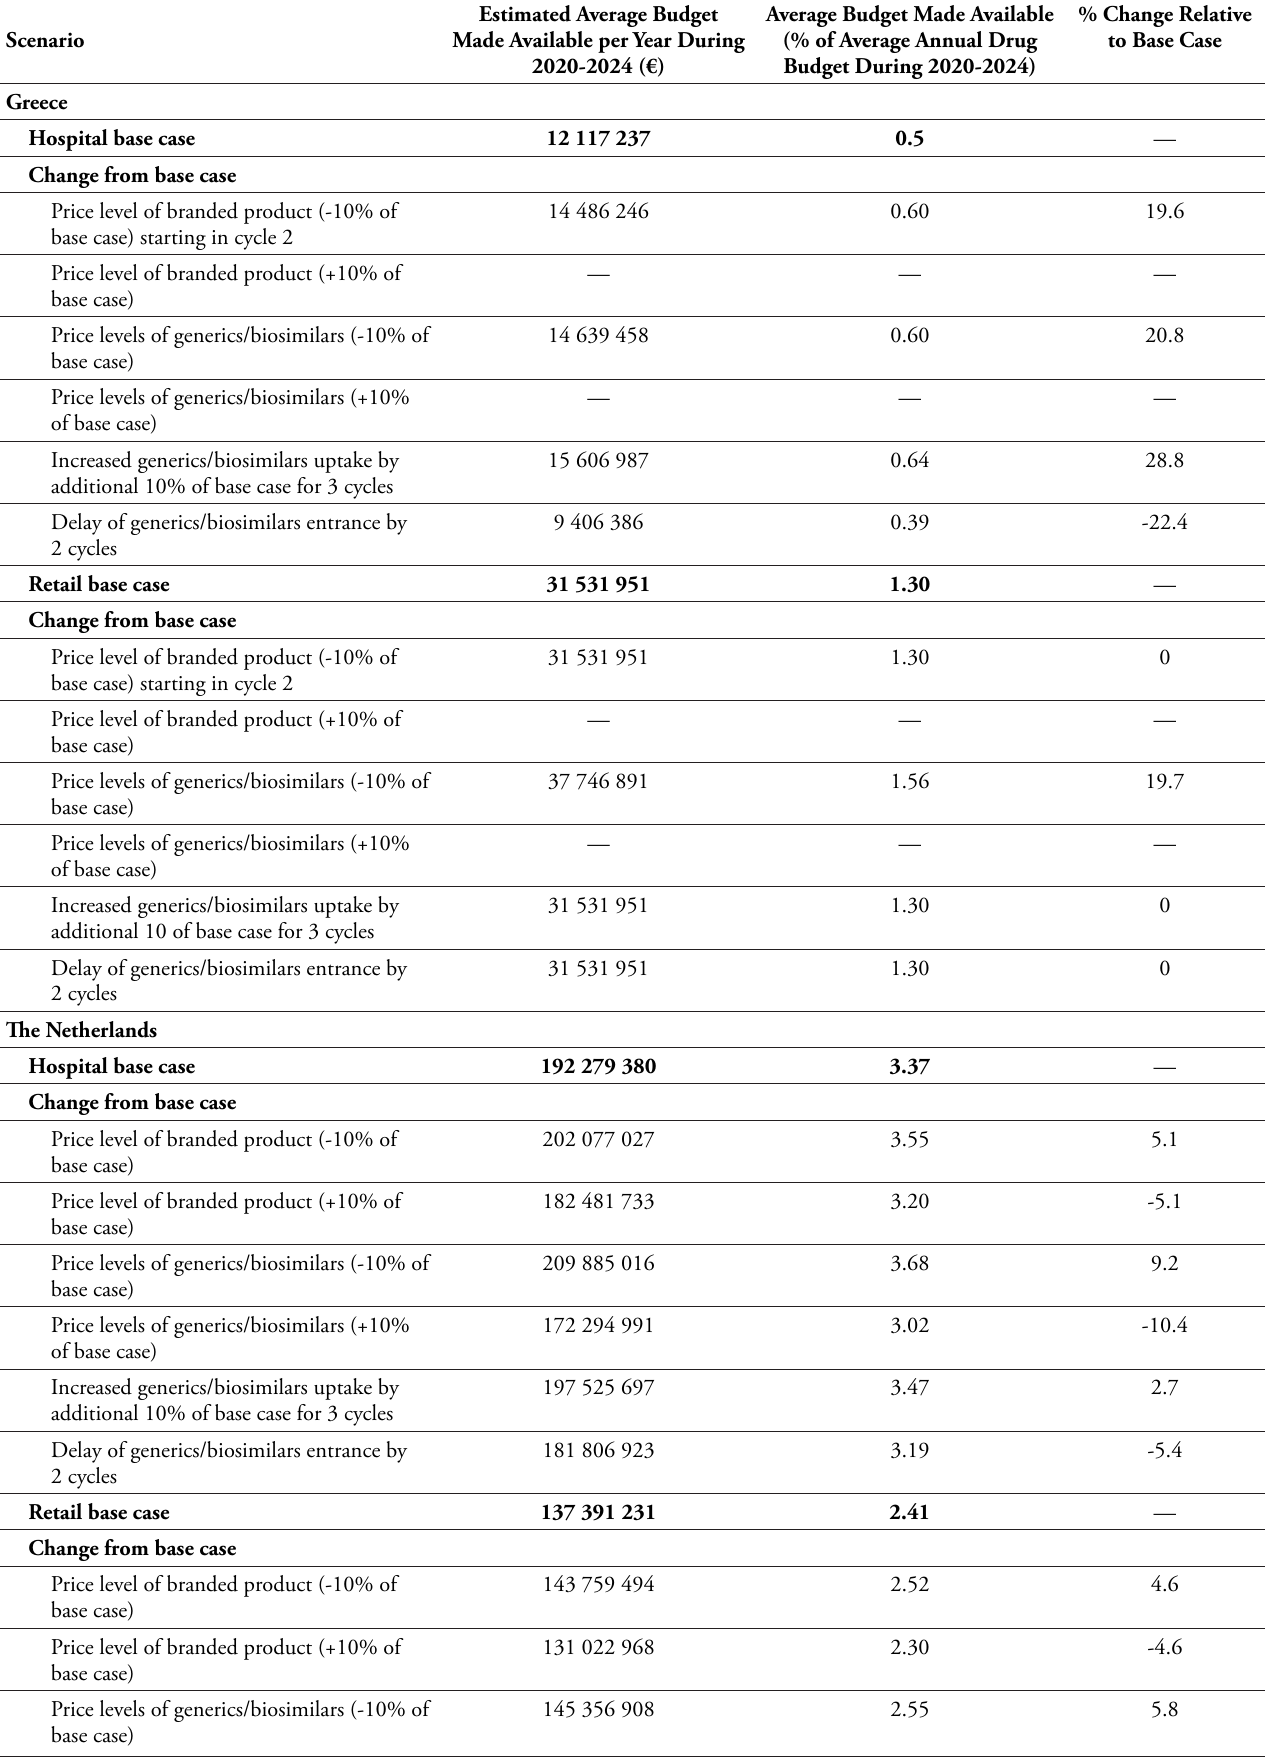
Table 4. One-Way Sensitivity Analysis on the Average Budget Made Available due to LOE During